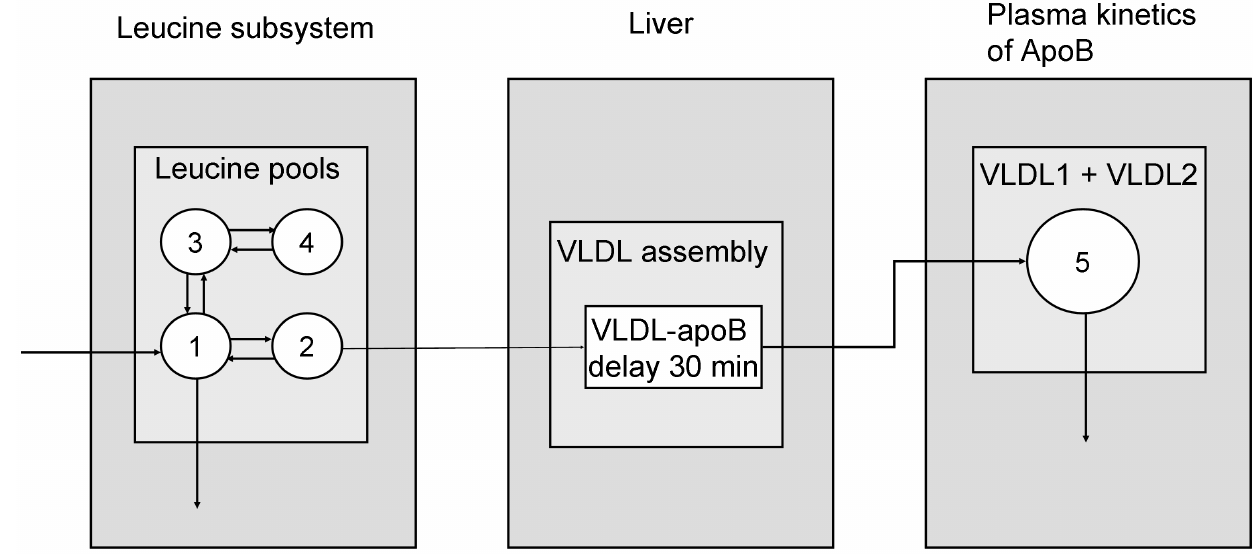
Figure 2. Schematic model of the compartmental model used for apolipoprotein B-100 (apoB) kinetic analysis. The assembly of lipoprotein is modeled by 9-compartment delay for apoB. The plasma apoB kinetic is modeled by a single hydrolysis step. Only a single VLDL lipoprotein fraction is considered, consisting of the VLDL1 and VLDL2 fractions in Adiels et al [29]. The free leucine plasma kinetics is modeled by two pools (3 and 4) and a plasma compartment (1), which interchange materials with an intracellular compartment (2). Compartment 2 feeds the apoB synthetic machinery.